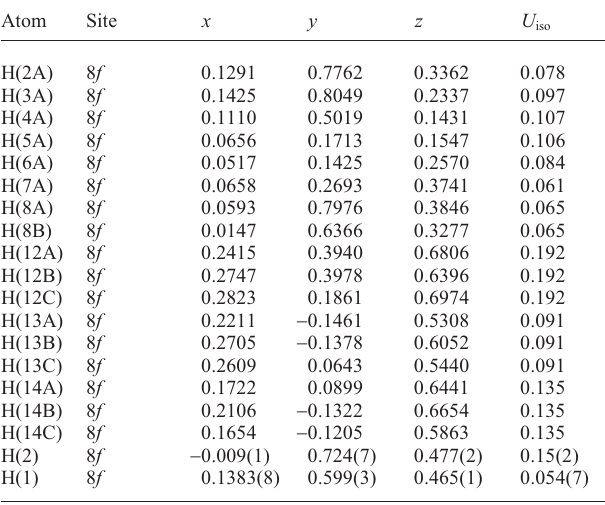
Table 2. Atomic coordinates and displacement parameters (in Å 2 )